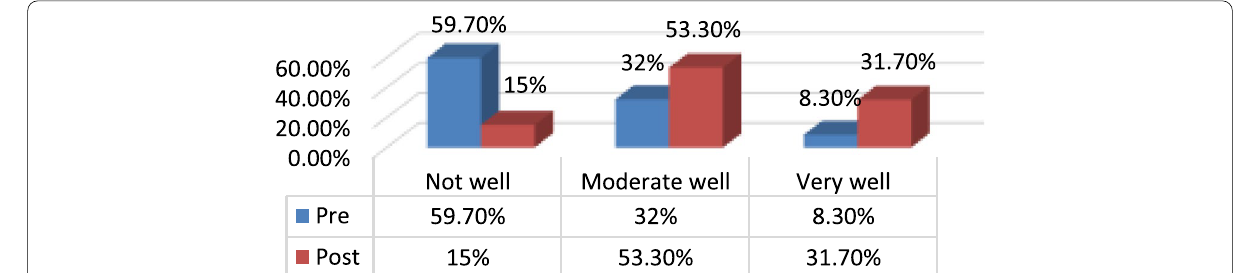
Fig. 3 How well the teacher recognized the signs of a student being a bully and a victim of bullying